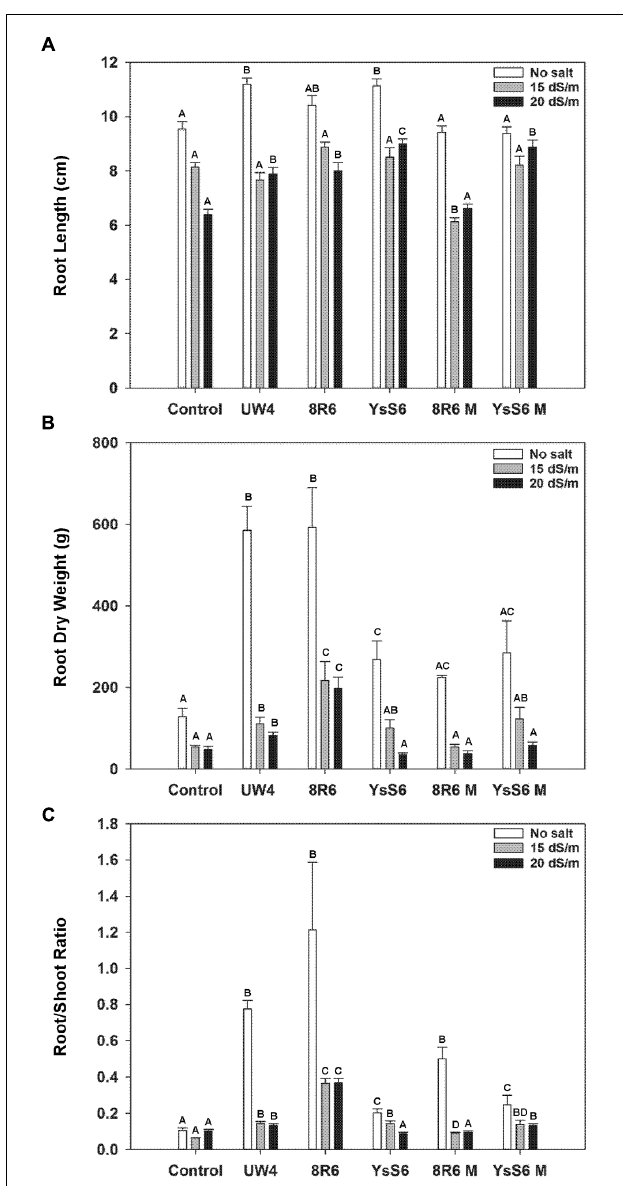
FIGURE 2 | The effect of soil inoculation with PGPB on root development of camelina plants grown in the absence, or presence of, salt (15 and 20 dSm − 1 ). Soil was treated with buffer (control), P. putida UW4, P. migulae 8R6 or its acdS mutant 8R6M, P. fluorescens YsS6 or its acdS mutant YsS6M. Salt was applied 20 days after sowing. Panels show root length (A) , root dry weight (B) , and ratio of root weight to shoot weight 41 days after sowing (C) . Error bars indicate standard error ( n = 15). A two-way ANOVA and Tukey post-test were used to detect significant differences between groups. Capital letters above bars indicate values that are significantly different ( p < 0.05) between treatments for each salt concentration.